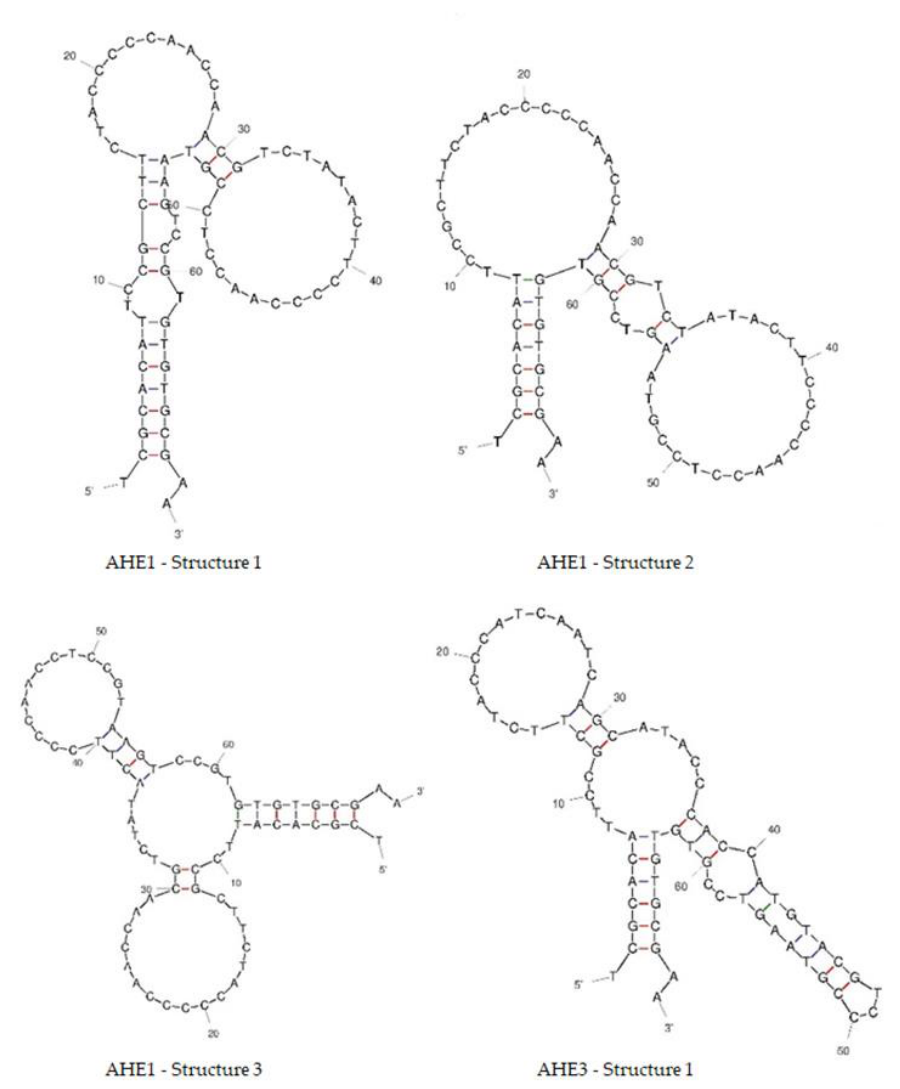
Figure 5. Predicted secondary structures of anti-HE4 aptamers. The secondary structures of DNA aptamers (AHE1 have three potential structures, AHE3 has one potential structure predicted) in- cluding full length 70-mer sequences were created using online DNA folding software Unafold (http://www.unafold.org) at temperature 25 ◦ C and urine concentration of [Na + ] = 55.4 mM and [Mg 2+ ] = 4.4